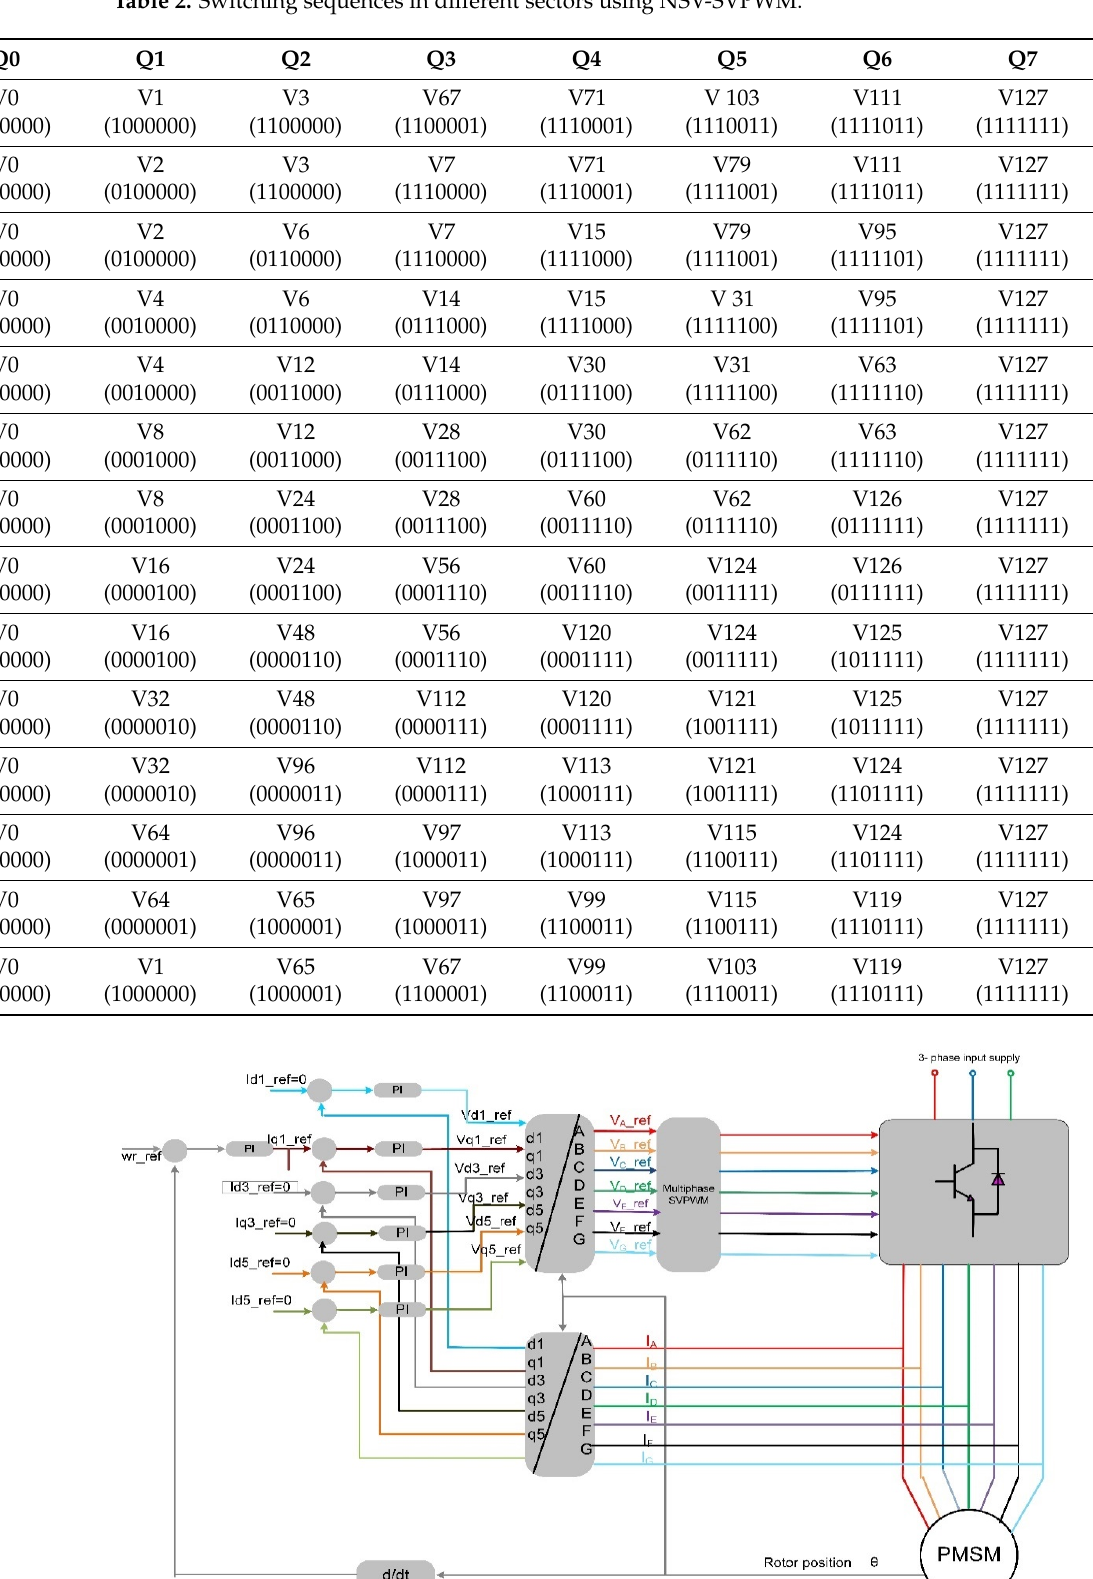
Figure 6. Sensored operation of the five phase motor. It can be noticed from Figure 6 that motor speed was controlled to 120 rpm and the stator currents were distributed symmetrically and shifted by ( 2𝜋/7 ). Moreover, the spectrum of the stator currents shows that there are no 3rd and 5th harmonics in the stator currents as they are controlled to zero. It can be noticed also that the ratio between the duration of the applied vectors completely agrees with what is given in Equations (13) and (14). 3. Algorithms to Extract the Rotor Position in Seven-Phase PMSMs without Encoders